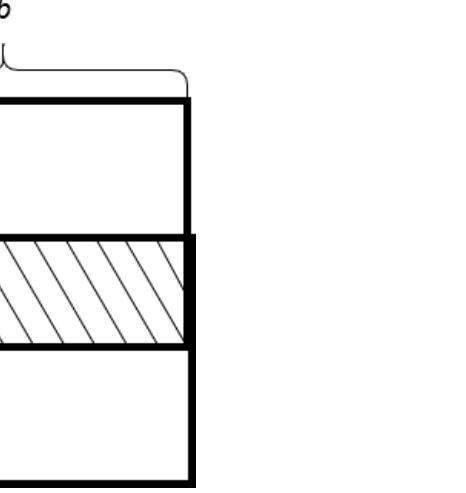
Figure 7. Two overlapped images from the camera, captured in the different height. a and b are the height and width of the camera